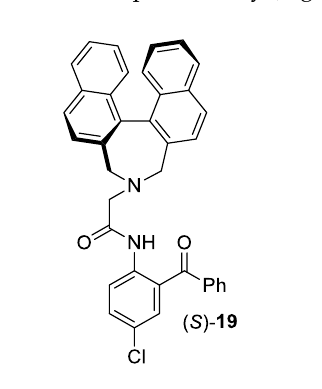
Figure 2. Structure of Hamari ligand.